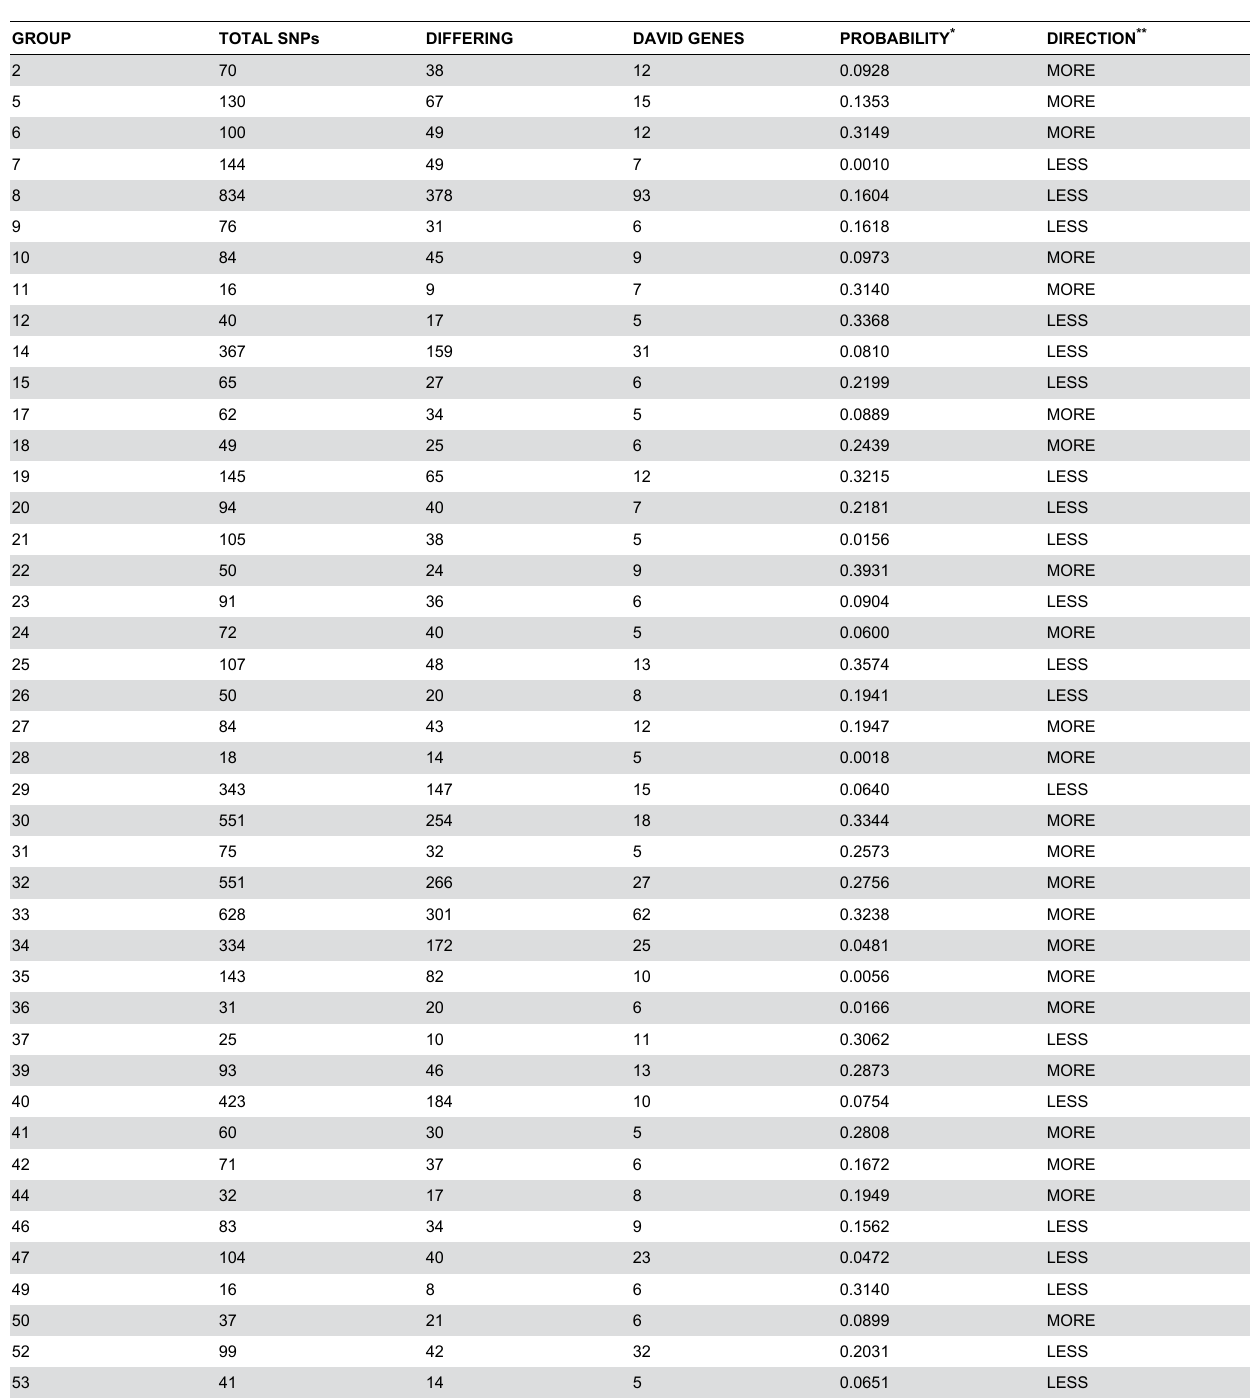
Table 2. Functional groups with significantly increased numbers of PAFs differing from HapMap CEU.